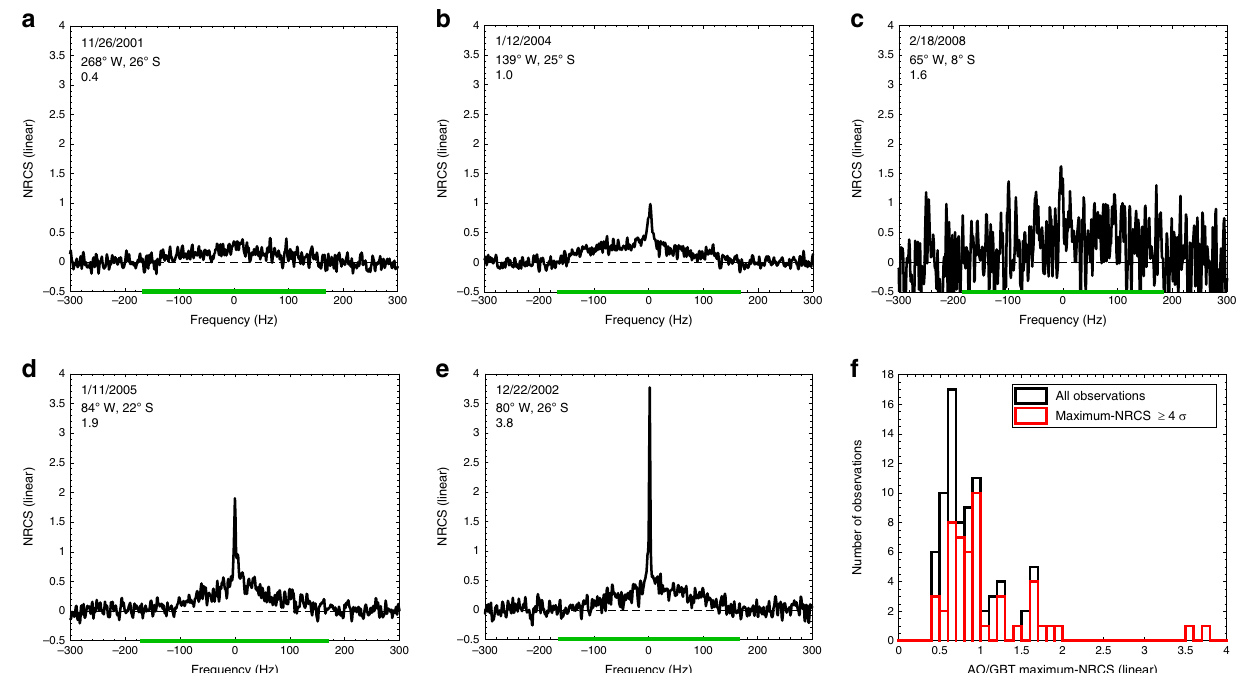
Fig. 1 Arecibo Observatory and Green Bank Telescope observations of Saturn ’ s moon Titan. a – e Example AO/GBT echo spectra of Titan in the opposite circular polarization channel, adapted from Black et al. 2 . The observation date, subradar location on Titan, and maximum-NRCS are in the panel legends. The width of the echo from Titan is indicated by the green line on the x -axis; data beyond the green line are indicative of the noise. All AO/GBT spectra from Titan have a broad, diffuse component with an NRCS of approximately zero at the limits of the echo (endpoints of the green line on the x-axis) that increases toward the center. The NRCS of the central Doppler bin varies drastically between the spectra. Observations with anomalously high peaks (e.g., d and e ) are the AO/GBT anomalously specular radar re fl ections. c Example demonstrating that the maximum-NRCS of some observations may be affected by noise. f Histograms of the maximum-NRCS of AO/GBT observations of Titan reported in Black et al. 2 . The black histogram includes all 83 observations and the red histogram includes only observations where the maximum-NRCS is ≥ 4 times the standard deviation of the noise ( σ ), to distinguish between observations with a high maximum-NRCS that may be due to greater noise and those that are con fi dently anomalous. Two observations have a maximum-NRCS ≥ 3.5 and are clearly separate from the distribution and thus anomalously specular. Another group of observations, with 1.5 ≈ < maximum-NRCS ≤ 2, is also separate from most observations; these observations are also anomalously specular, albeit less so than the two observations with maximum-NRCS ≥